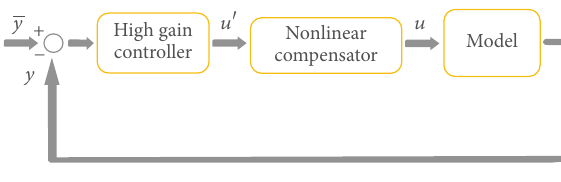
Figure 3: Control